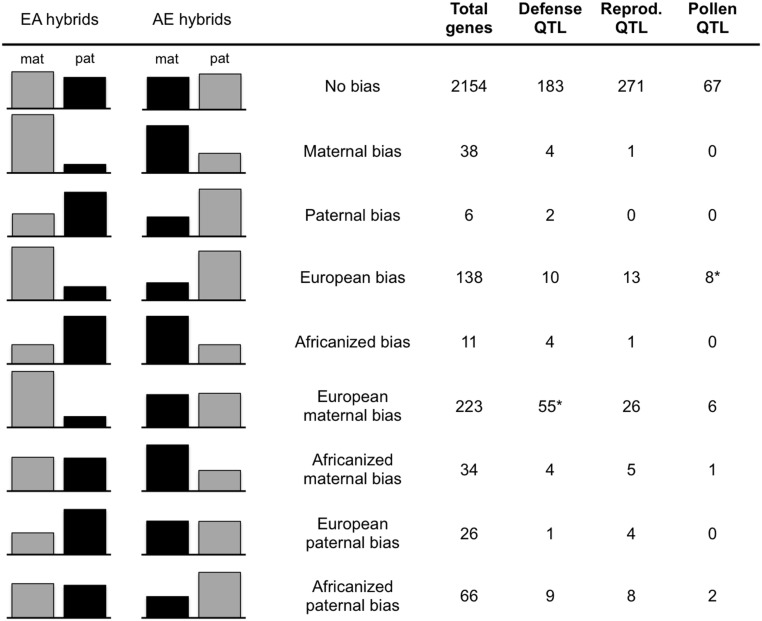
Gene counts in bias categories. Average maternal/paternal bias of all genes in each bias category in each hybrid family (EA, European maternity; AE, Africanized maternity). Gray columns = European allele, Black = Africanized allele. The total number of genes in each category and the number falling in each QTL type are given in the columns on the right. Only genes falling into a single bias category across samples are included in counts for QTL types. ∗Significantly more genes in this category are present within these QTL than expected by chance (Bonferroni corrected p-value = 0.005).